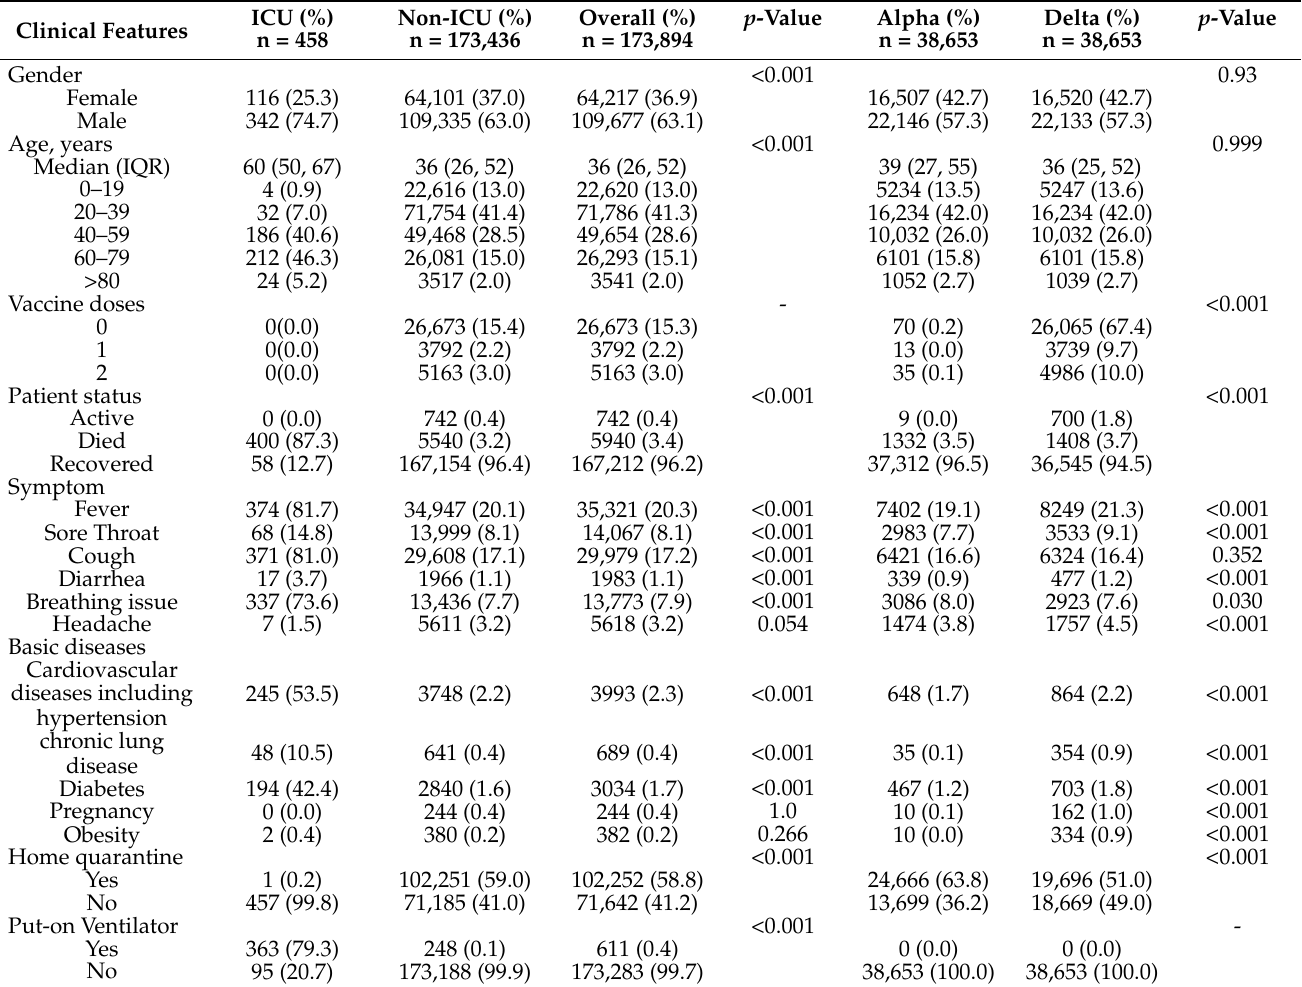
Table 1. Demographic characteristics of all SARS-CoV-2 cases and matched cases during the Alpha and Delta